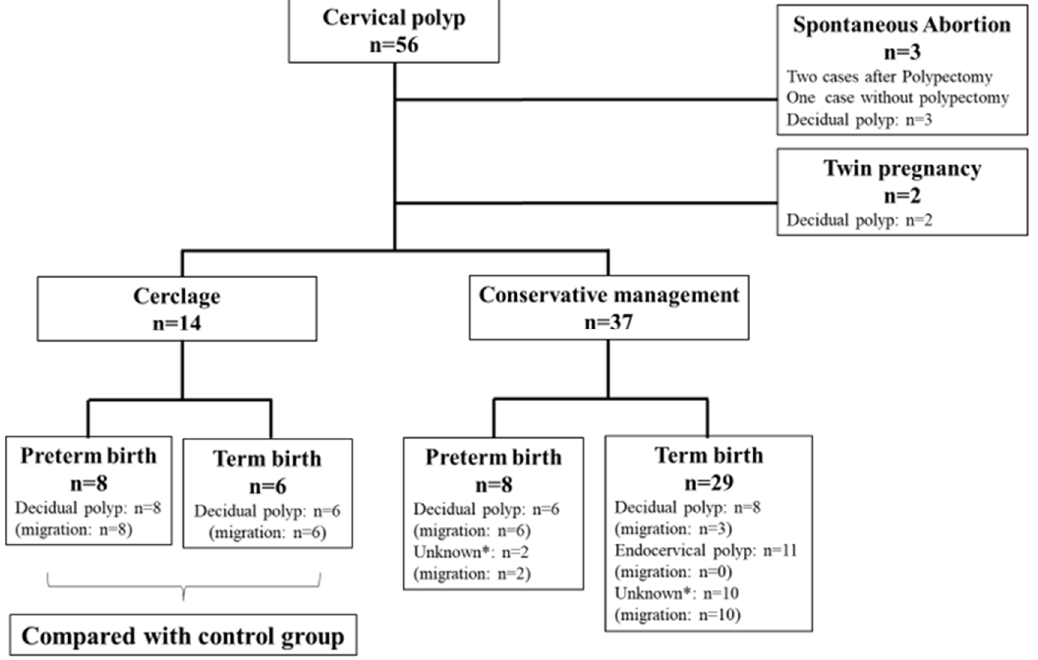
Figure 2. Patient flow diagram. *Unknown: cases without pathological confirmation because of migration and/or severe degeneration.